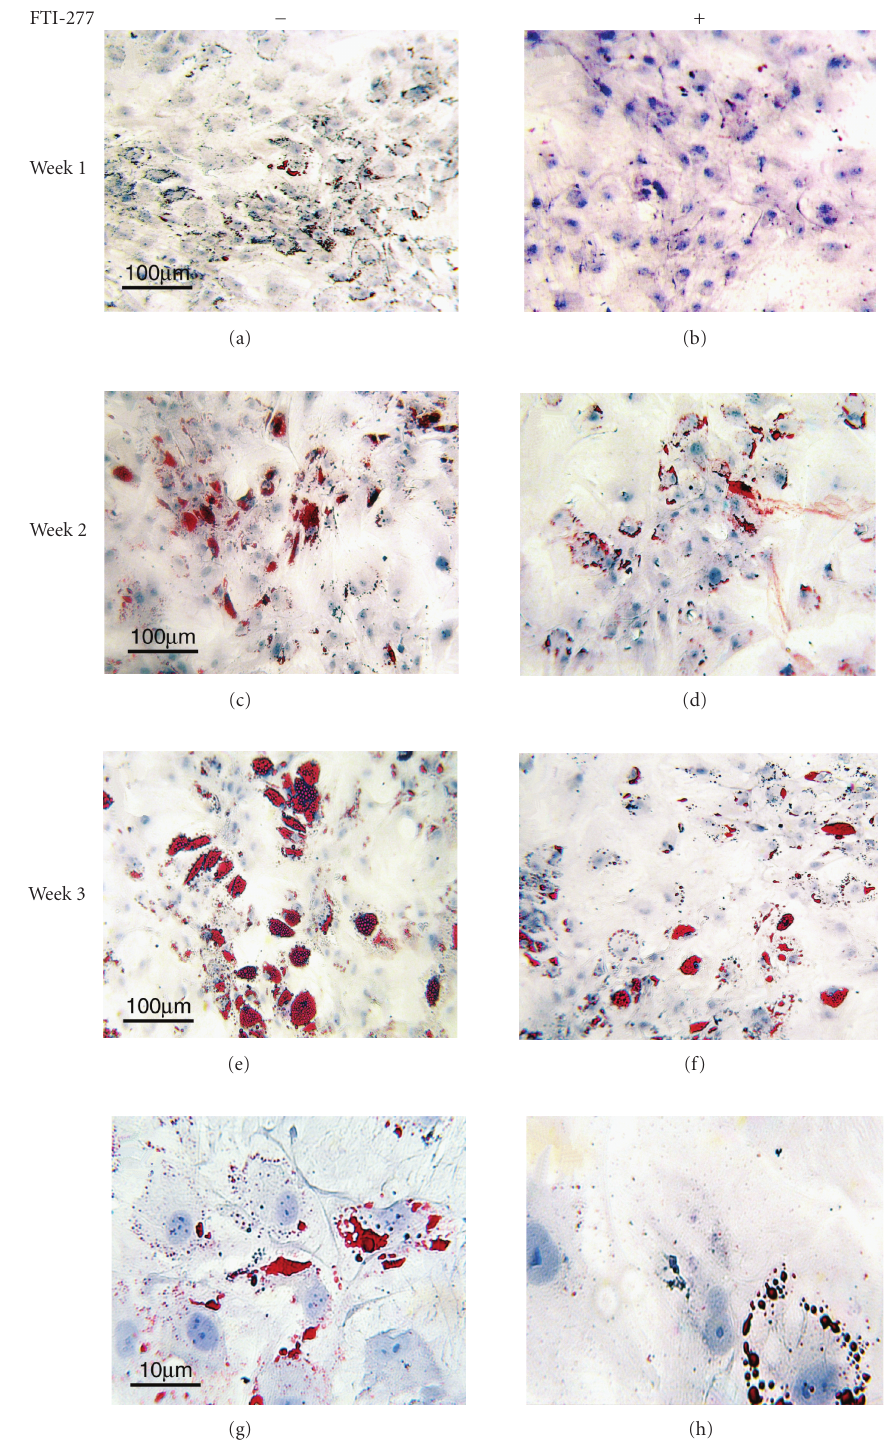
Figure 1: E ff ect of FTI-277on adipogenesis: human MSCs were committed to di ff erentiate into adipocytes and treated for three weeks with either FTI-277 (5 μ M) (b, d, f, and h) or vehicle alone (a, c, e, and g). At timed intervals (week 1 (a and b), week 2 (c and d), and week 3 (e and f)), cells were fixed, stained with oil red o, and counterstained with hematoxylin to assess adipocyte di ff erentiation. Lower magnification (10 × ) shows higher amount of fat droplets (red) and di ff erentiated adipocytes in untreated cells at all time points (a, c, and e) as compared with FTI-277-treated cells (b, d, and f). At higher magnification (100 × ), the amount and distribution of fat droplets is highly a ff ected by treatment (h) where lipid droplets (red) are unable to reach confluence as compared with untreated cells (g). Note the changes in the cytoplasm after treatment (h) including vacuolization, irregular nuclei, and “mega”